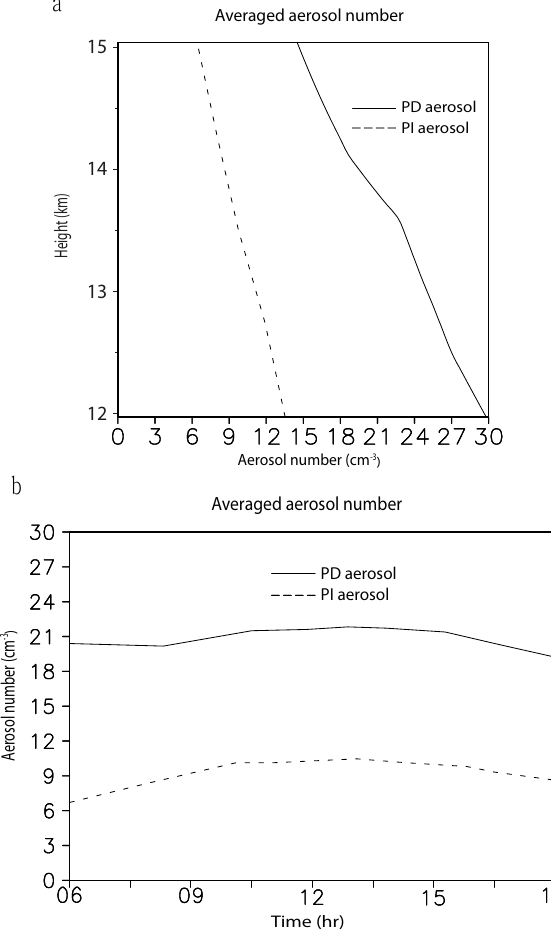
Fig. 3. (a) Vertical distribution of the time- and area-averaged back- ground aerosol number concentration and (b) the time series of background aerosol number concentration averaged over the layer between 12 and